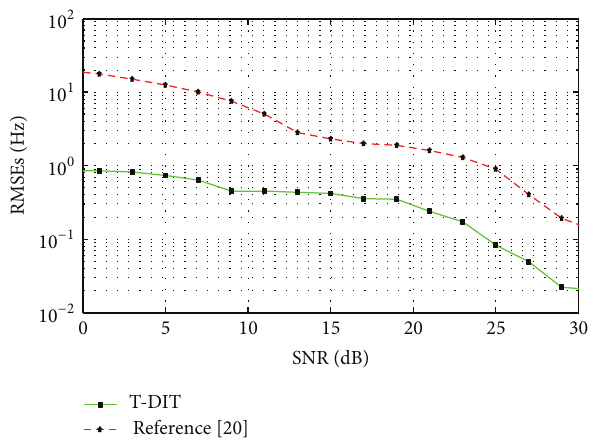
Figure 10: The moving target azimuth angles during flight course.